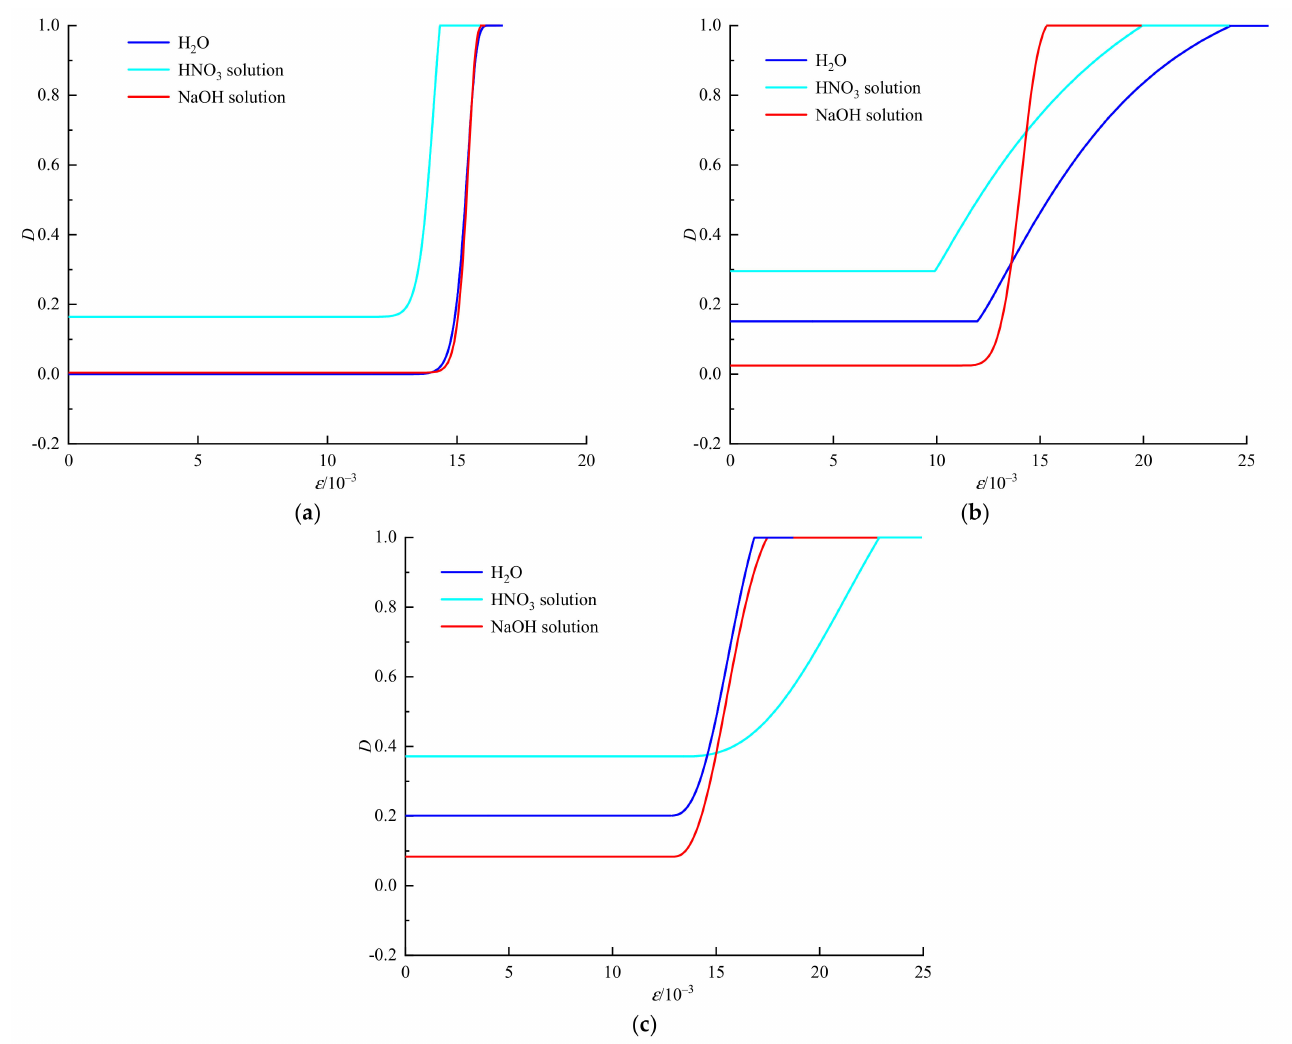
Figure 6. Damage evolution curves of uniaxial compression under different chemical solutions and freeze-thaw cycles: ( a ) Freeze-thaw 0 times; ( b ) Freeze-thaw 75 times; ( c ) Freeze-thaw 100